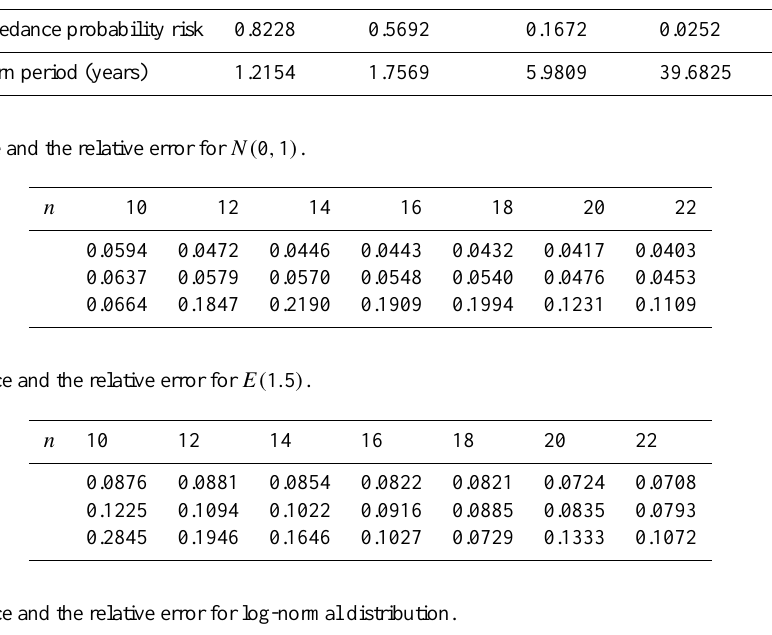
Table 8. Flood disaster risk evaluation values.